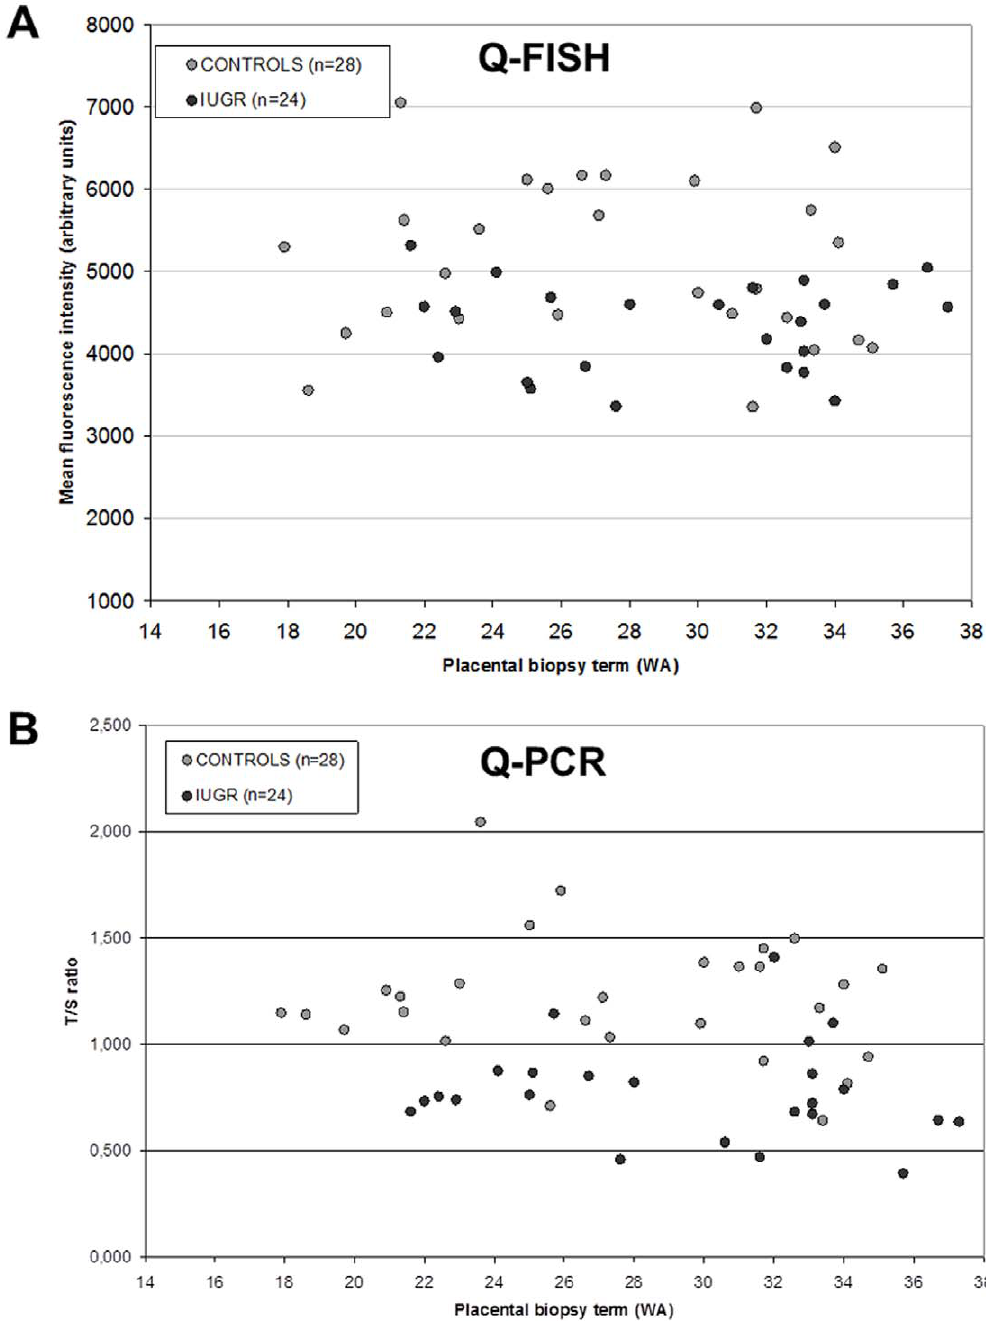
Figure 1. Placental telomere length estimated from late chorionic villus samplings by two quantitative techniques. A. Quantitative Fluorescence In Situ Hybridization (Q-FISH). Telomere fluorescence intensity of Peptide Nucleic Acid probes (arbitrary units) as a function of pregnancy term of placental biopsy (expressed in weeks of amenorrhea (WA)) for the 28 controls (light grey circles) and the 24 cases with intrauterine growth restriction (IUGR) (dark grey circles). B. Quantitative Polymerase Chain Reaction (Q-PCR). T/S ratios (no unit) as a function of pregnancy term of placental biopsy (expressed in WA) for the 28 controls (light grey circles) and the 24 cases with IUGR (dark grey circles).